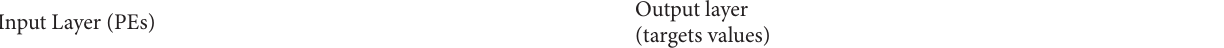
The maximum and the minimum daily value of PET of